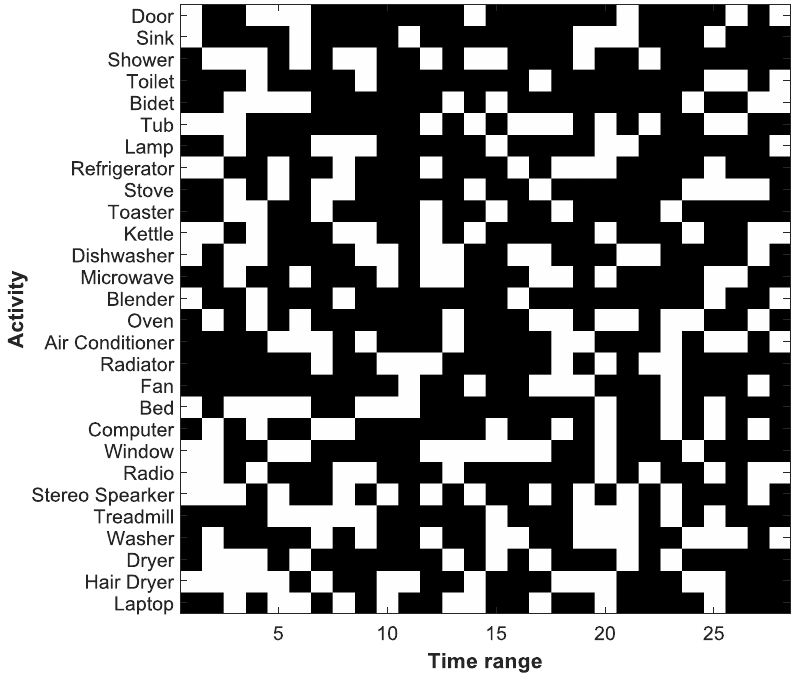
Figure 4. Visualization of activity